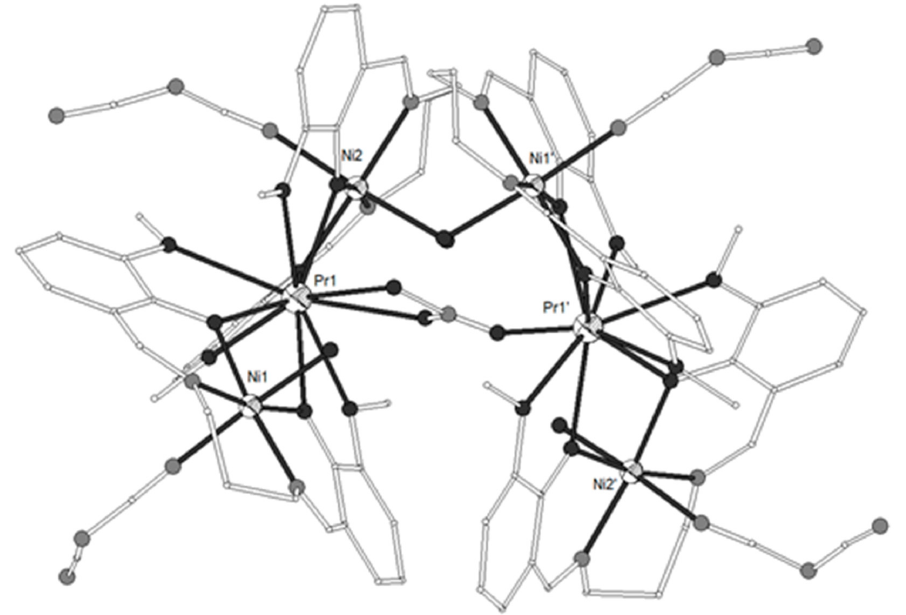
Figure 16. The molecular structure of the cationic complex [{{(NiL 30 (H 2 O))(N(CN) 2 )} 2 Pr} 2 ( μ -NO 3 )] + ( 146 ). Primed atoms are generated by symmetry (‘) 1 − x , y , 0.5 − z . Color code: Pr large octant, Ni small octant, N light grey, O dark grey, C open small [52].